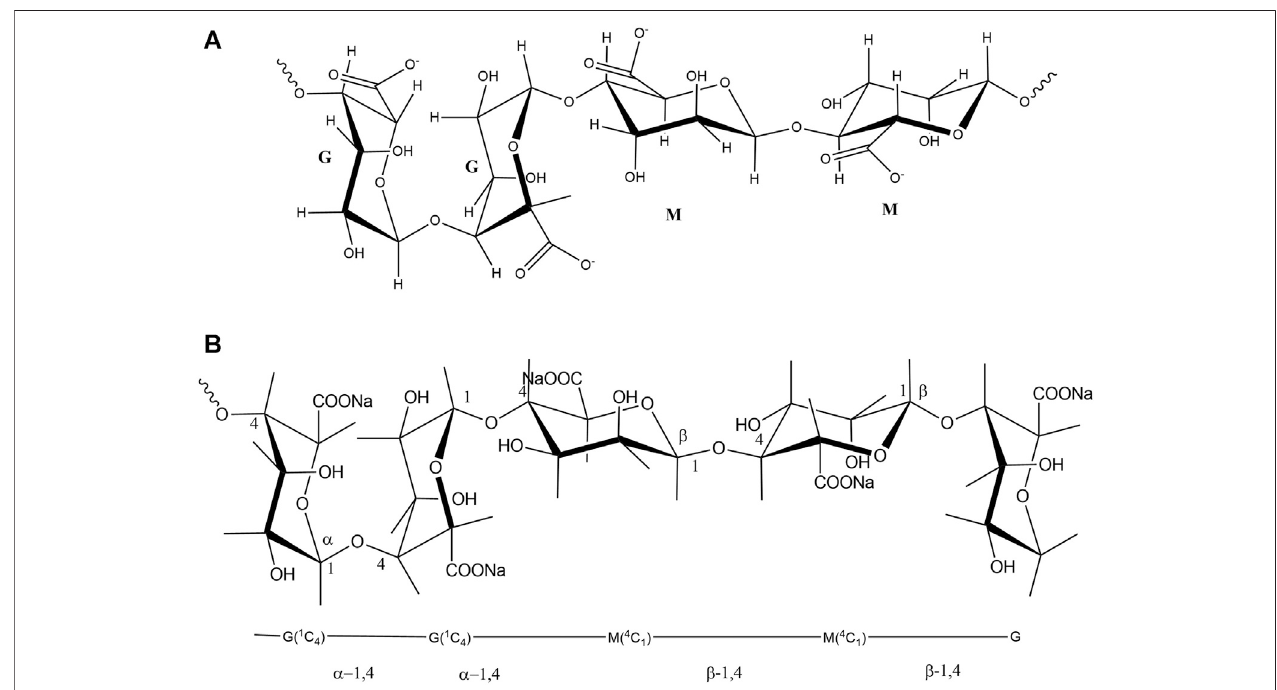
FIGURE 1 | (A) : Chemical structures of alginate, indicating two acid groups, (B) : the linkage and bonding of mannuronic and guluronic groups.